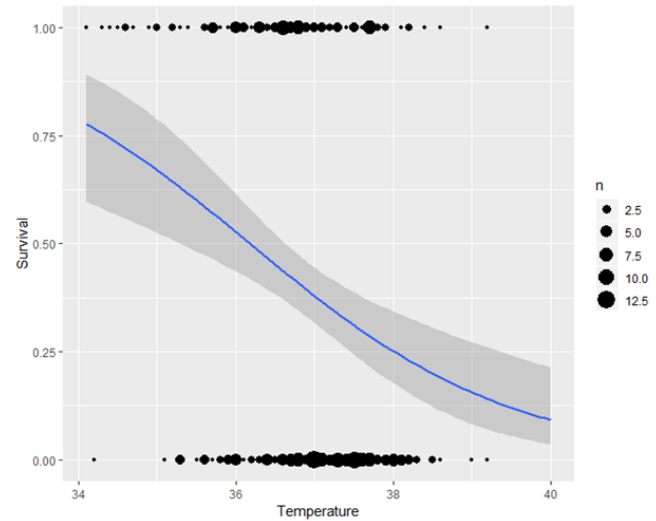
Figure 2. The rectal temperature (C°) at 0 h of piglets that survived (0) and died (1).